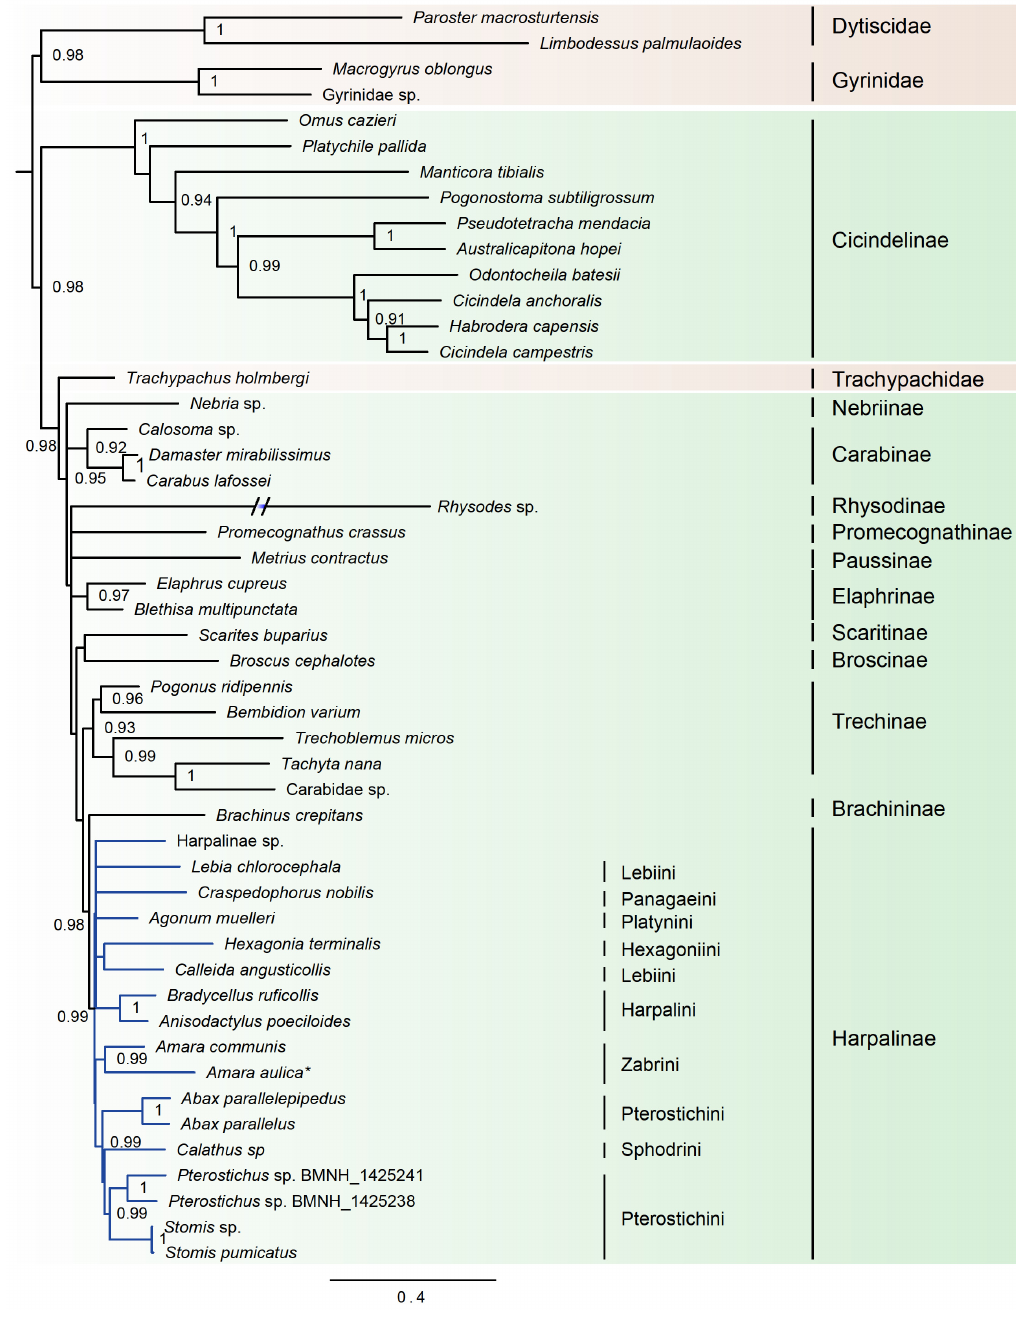
Figure 3. Bayesian tree inferred from the dataset of 49taxa_PCGRNA using PhyloBayes under the site-heterogeneous CAT-GTR model. Poster probability values ( ≥ 50) are indicated near the nodes. The branch of Rhysodes is depicted as half of its original branch length. Green background indicates the ingroup taxa of Carabidae, and brown indicates the outgroups. Blue lines indicate the Harpalinae. The newly determined Amara aulica is emphasized by asterisk.